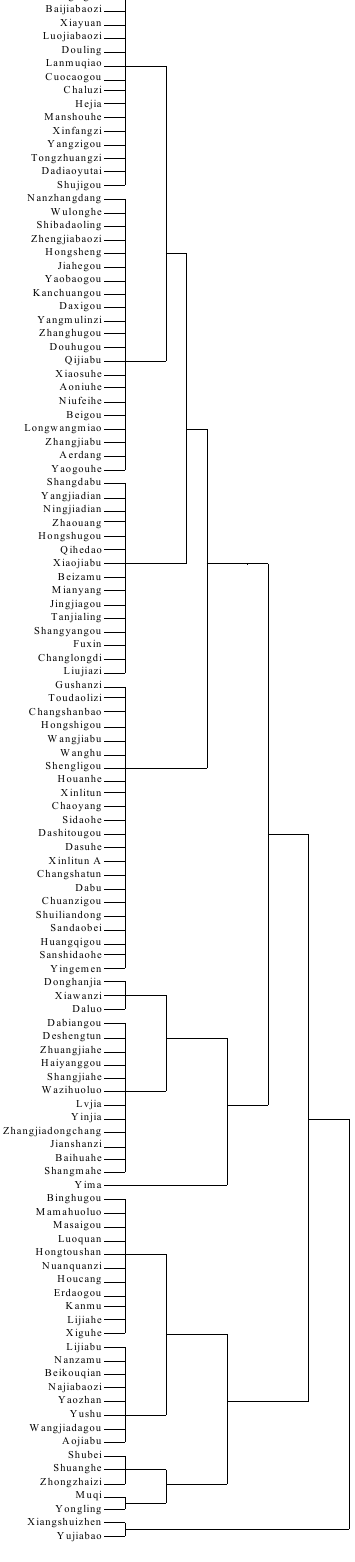
Figure 4. The result of K- means clustering analysis.